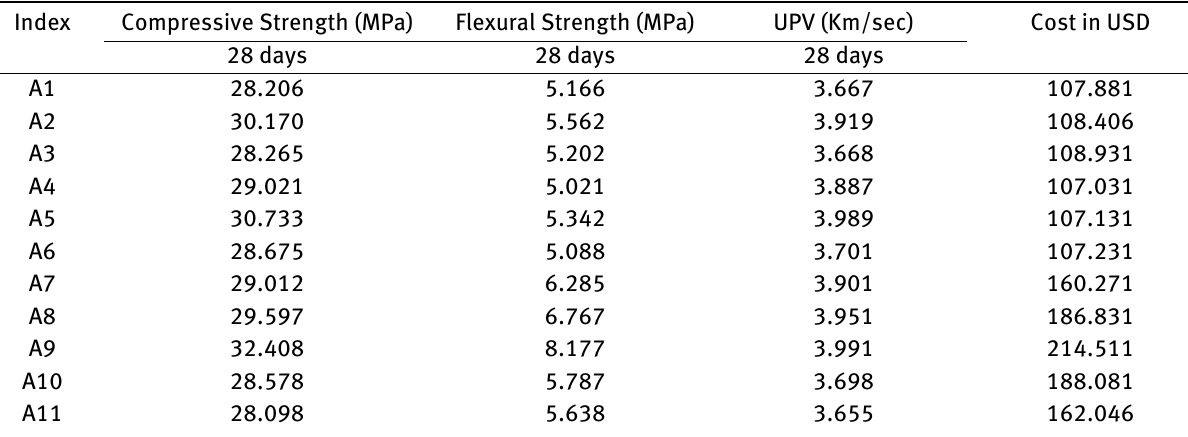
Table 16: The alternatives and criteria used in TOPSIS method for ranking of reinforced green mortars.